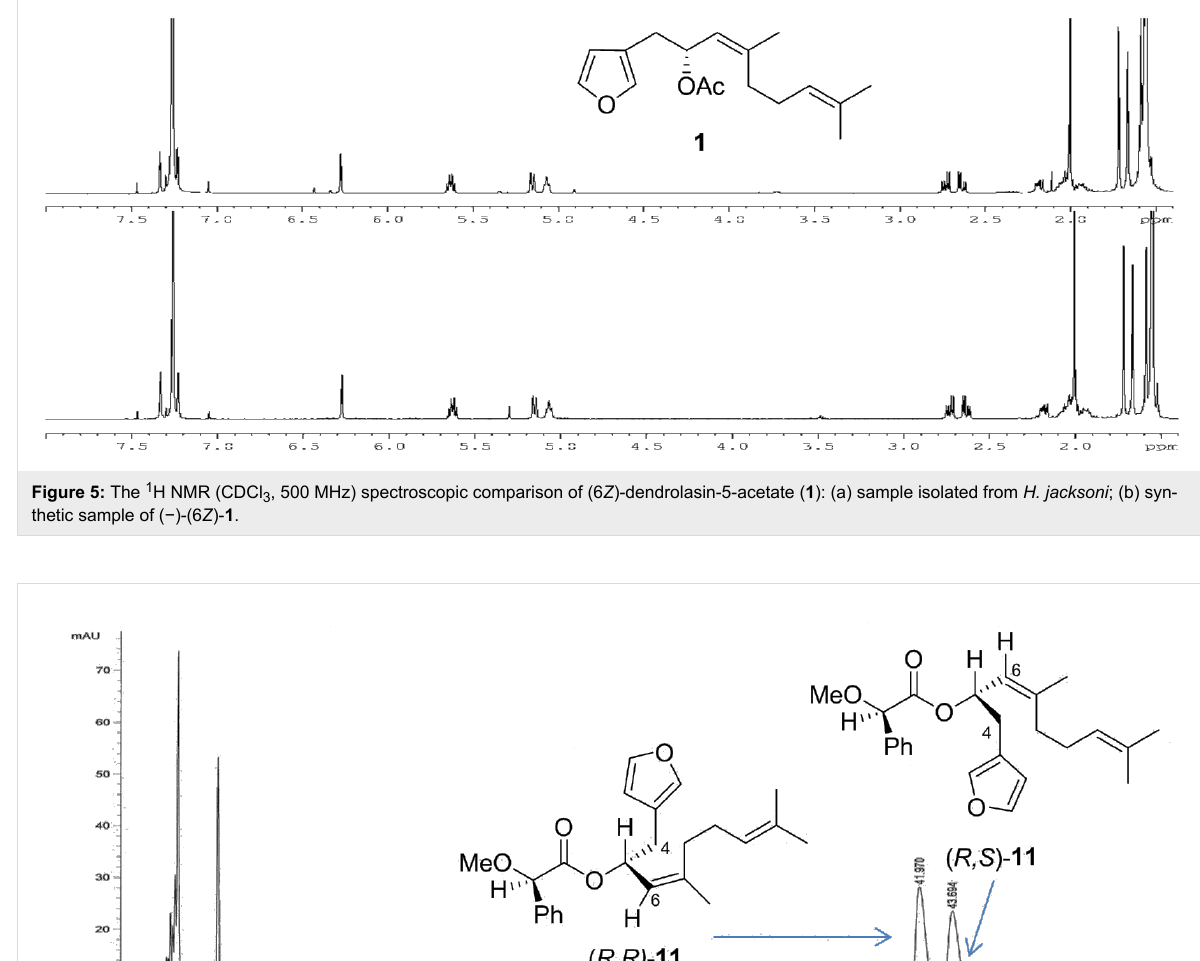
Figure 6: RP HPLC trace showing separation of the MPA esters ( R,R )- 11 and ( R,S )- 11 (MeCN/H 2 O, 63:35 over 50 minutes, Phenomenex C-18 column, 250 × 4.60 mm, UV detection at 254 nm).